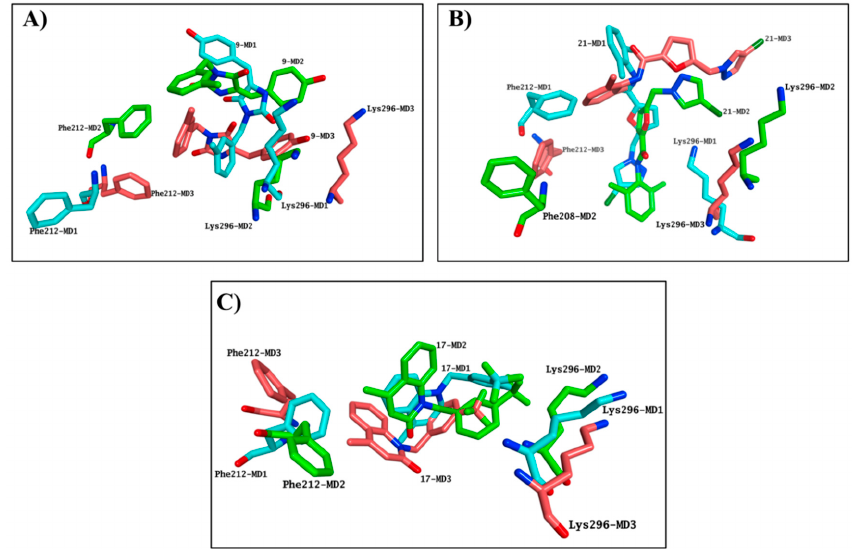
Figure 7. Compound 9 ( A ), 21 ( B ) and 17 ( C ) provided highly variable results in terms of occupation of the binding site, exhibiting a substantial different binding mode in each MD simulation performed. The last frames from each MD triplicate have been superposed. Only Phe212 and Lys296 are shown and the rest of rhodopsin is hidden for clarity. Carbon atoms colours: MD1-cyan MD2-green, MD3-salmon.